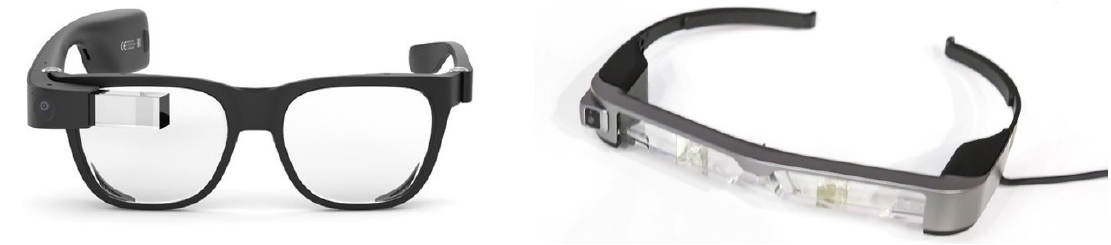
Figure 3. Google Glass Enterprise Edition 2 ( left ) and Epson Moverio AR glasses ( right ). Moverio BT-300FPV AR glasses by Epson (Suwa City, Japan) are optimized for drone flying: the video feed from the aircraft is displayed in first-person view (FPV) on a transparent screen, which allows the viewer to pilot the UAV, monitor its flight statistics, and keep the UAV always in sight (see Figure 3). In 2022, XYZ (London, UK) released The Atom, a next-generation engineering-grade AR headset for construction. Combining a safety-certified hard hat, augmented reality displays, and the in-built computing power of the platform HoloSite, the device can position holograms of BIM models on-site to millimeter accuracy.